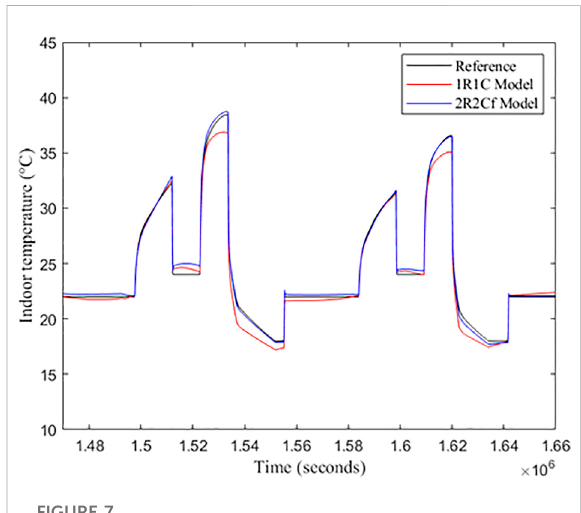
FIGURE 7 Simulated indoor temperature by models in active regime. FIGURE 8